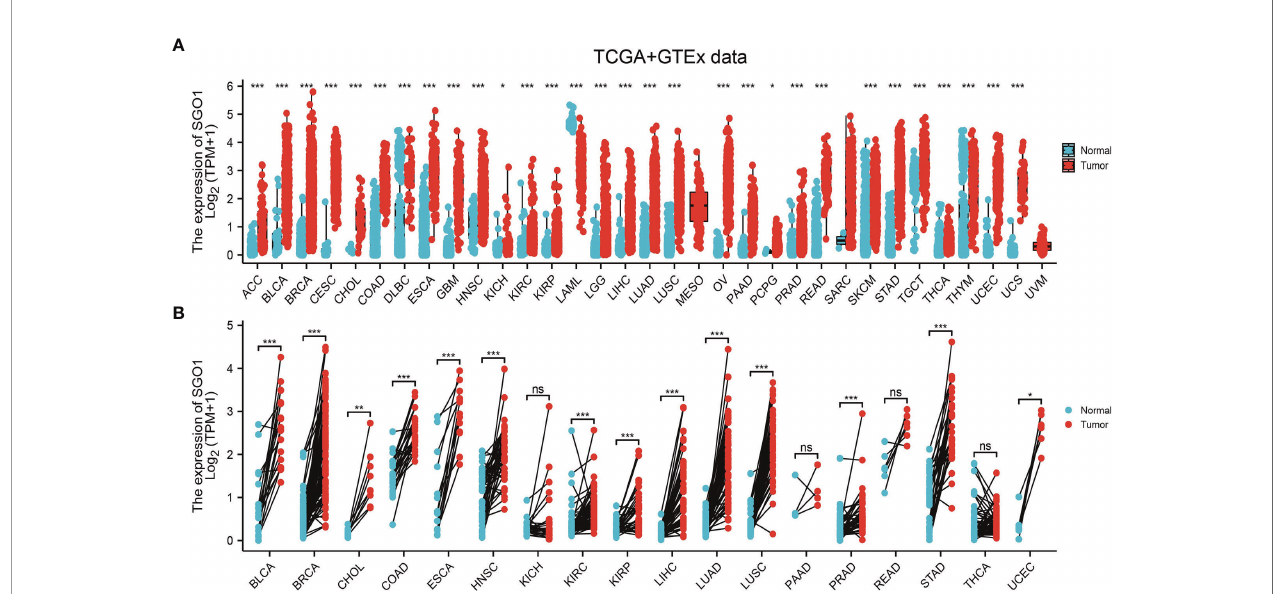
FIGURE 1 | The expression pattern of SGO1 in pan-cancer. (A, B) The expression of SGO1 in pan-cancer examine by TCGA. NS: P > 0.05, ***P < 0.001. ACC: adrenocortical carcinoma, BLCA: bladder urothelial carcinoma, BRCA: breast invasive carcinoma, CESC: cervical squamous cell carcinoma and endocervical adenocarcinoma, CHOL: cholangiocarcinoma, COAD: colon adenocarcinoma, DLBC: lymphoid neoplasm diffuse large B-cell lymphoma, ESCA: esophageal carcinoma, GBM: glioblastoma multiforme, HNSC: head and neck squamous cell carcinoma, KICH: kidney: chromophobe, KIRC: kidney renal clear cell carcinoma, KIRP: kidney renal papillary cell carcinoma, LAML: acute myeloid leukemia, LUAD: brain lower-grade glioma, LIHC: liver hepatocellular carcinoma, LUAD: lung adenocarcinoma, LUSC: lung squamous cell carcinoma, MESO: mesothelioma, OV: ovarian serous cystadenocarcinoma, PAAD: pancreatic adenocarcinoma, PCPG: pheochromocytoma and paraganglioma, PRAD: prostate adenocarcinoma, READ: rectum adenocarcinoma, SARC: sarcoma, SKCM: skin cutaneous melanoma, STAD: stomach adenocarcinoma, TGCT: testicular germ cell tumors, THCA: thyroid carcinoma, THYM: thymoma, UCEC: uterine corpus endometrial carcinoma, UCS: uterine carcinosarcoma, UVM: uveal melanoma. NS: P > 0.05, *P < 0.05, **P < 0.01, ***P < 0.001.